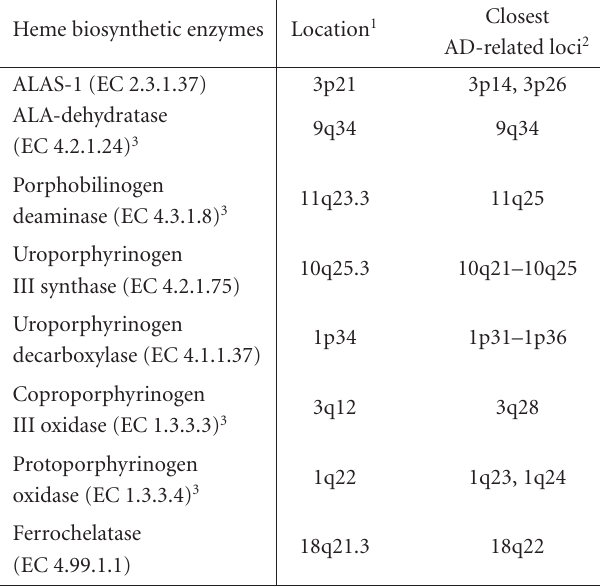
Table 1: Chromosomal locations of genes encoding enzymes of the heme biosynthesis pathway and genes linked to development of late- onset Alzheimer’s